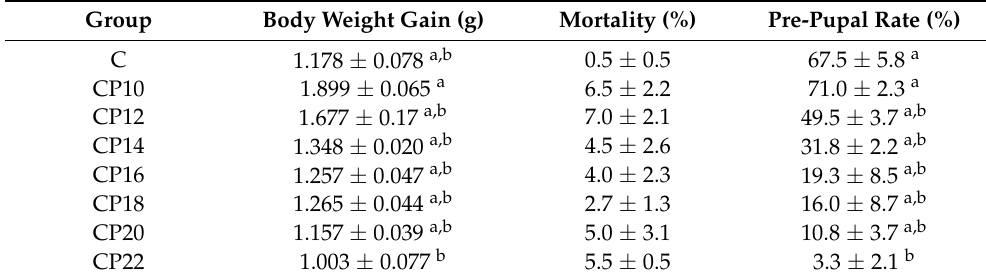
Table 3. Body weight gain, mortality, and pre-pupal rate of BSF larvae in Experiment